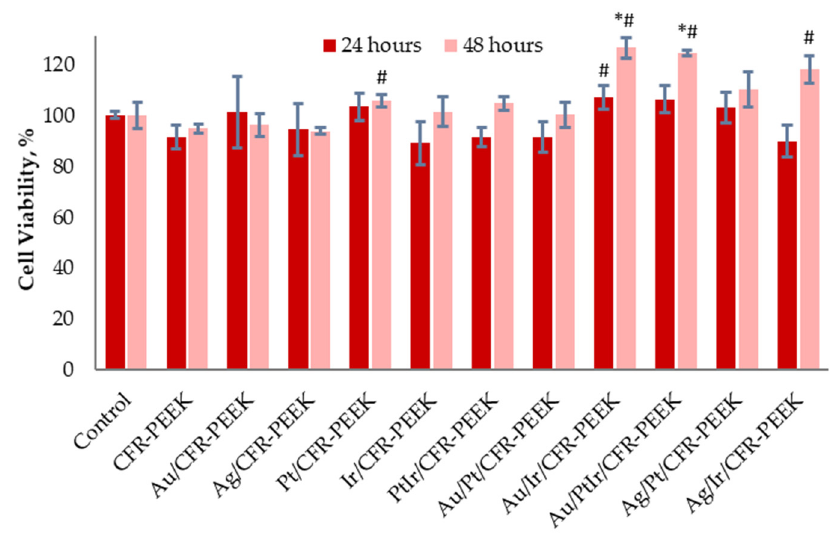
Figure 10. L-929 cell viability after 24 and 48 h of cultivation with extracts of pristine and coated CFR-PEEK samples with different noble metals. * p < 0.05 (as compared to the control group). # p < 0.05 (as compared to the pristine CFR-PEEK group).